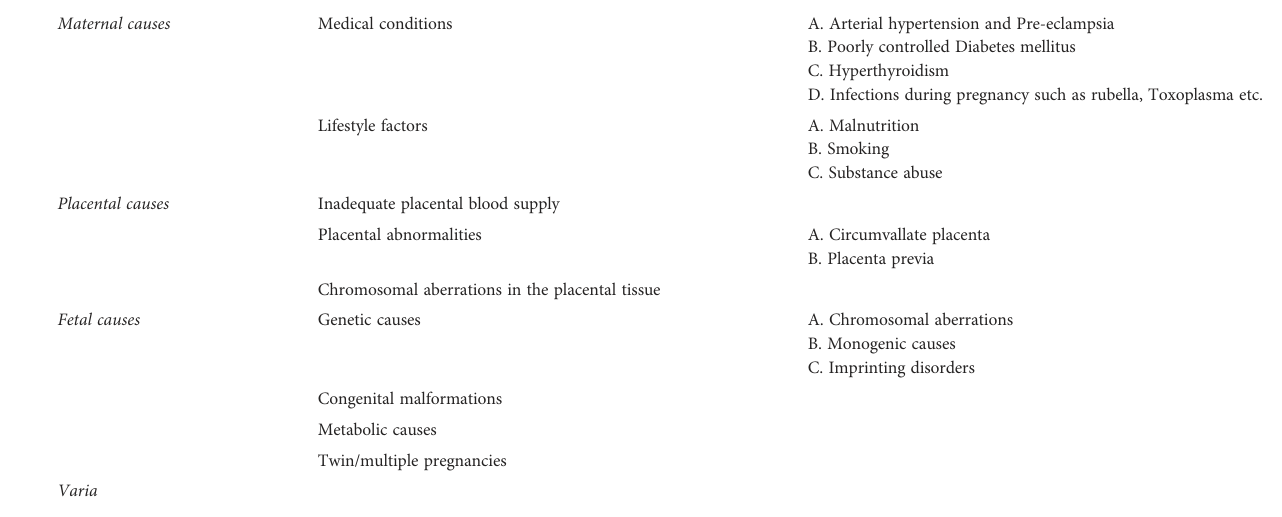
TABLE 1 Causes of intrauterine growth